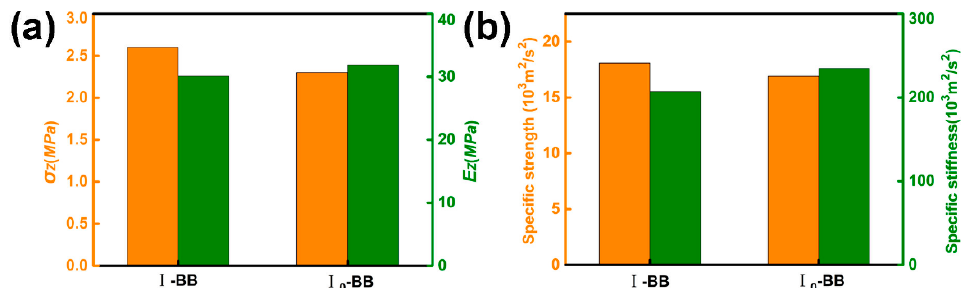
Figure 9. ( a ) Compressive strength and Young’s modulus ( b ) Specific strength and specific stiffness.